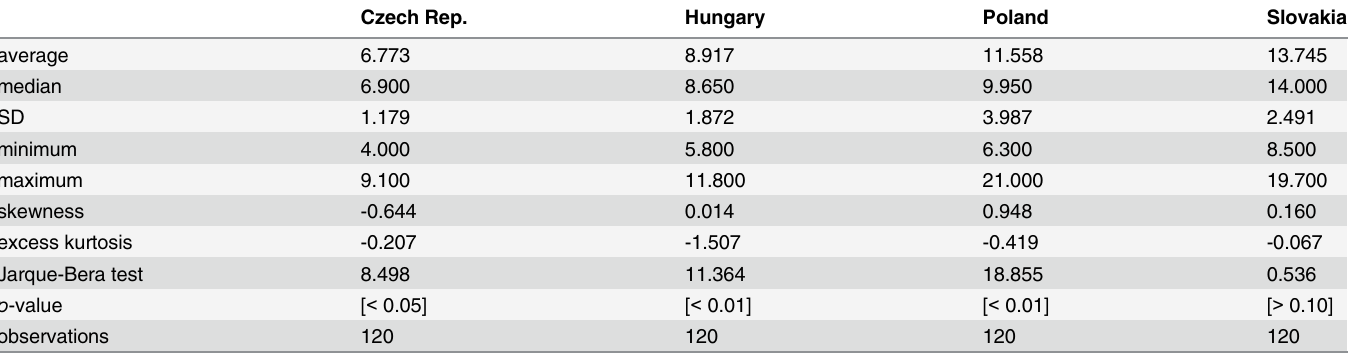
Table 1. Summary statistics. Jarque-Bera test with the null hypothesis of a symmetric distribution with no excess kurtosis is used here, p -values are re- ported in the brackets. Czech